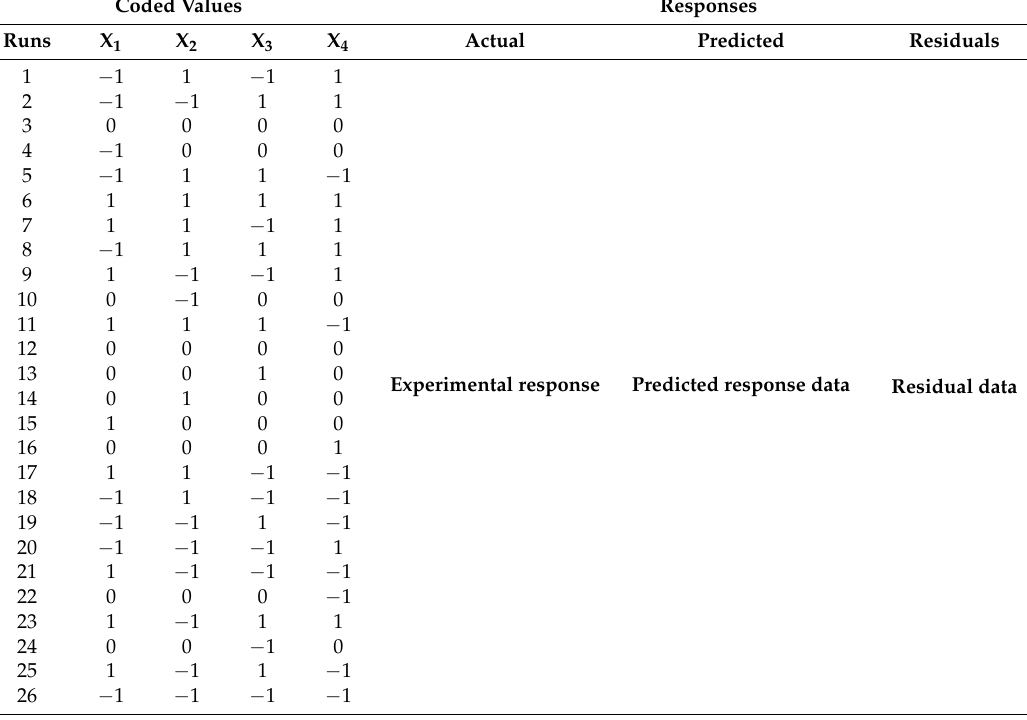
Table 8. Central Composite Design of four independent factors (labelled X 1 , X 2 , X 3 , X 4 respectively) studied at two levels (+1 and − 1) including two central point replicates (0 and 0). The table also shows different types of common responses found in optimisation process; (1) Actual data refers to experimental results; (2) predicted data are generated by software based on the design and actual results. The residuals are the difference between actual and predicted data.